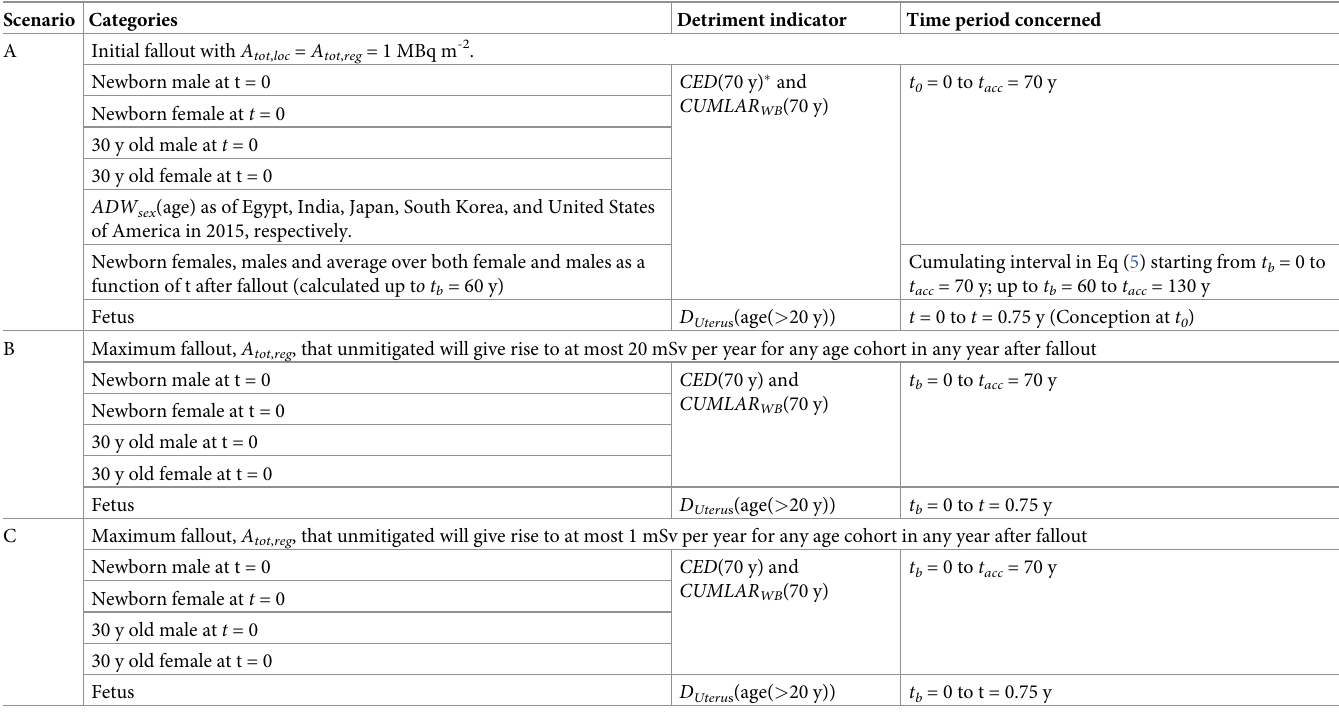
Table 5. Overview of fallout scenarios, calculated detriment estimates and time frames considered in this model assessment. Scenario